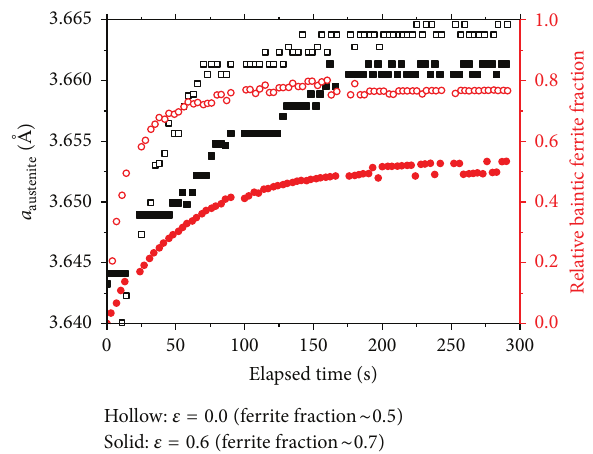
Figure 7: The measured lattice parameter of austenite during the formation of the carbide-free bainite, implying the carbon enrichment in austenite.